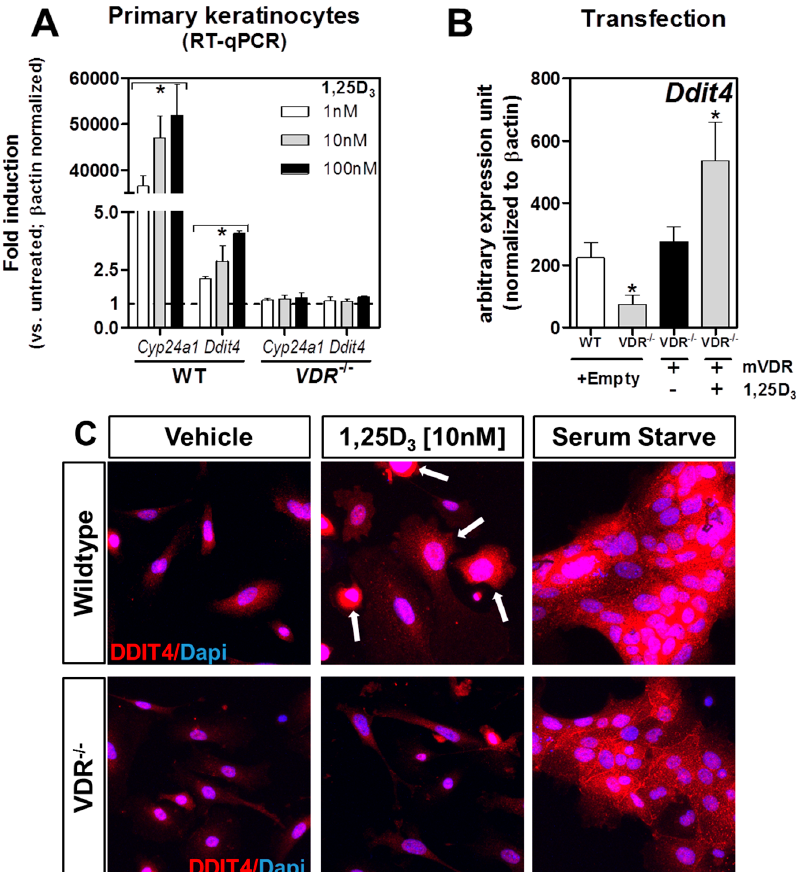
Figure 2. Regulation of the mechanistic/mammalian target of rapamycin (mTOR) inhibitor and stress sensor DNA damage-inducible transcript 4 (Ddit4) by liganded vitamin D receptors (VDRs) within primary keratinocytes (column 1.5). ( A ) Dose-dependent transcriptional induction of Cyp24a1 and Ddit4 by 1,25-dihydroxyvitamin D (1,25D 3 , 6 h) in wildtype (WT), but not VDR − / − , primary keratinocytes derived from neonatal pups; ( B ) Transient transfection of VDR − / − primary keratinocytes with a mVDR plasmid restores endogenous Ddit4 transcript levels. Combined treatment further enhanced Ddit4 mRNA levels (with mVDR transfection and 1,25D 3 of 10 nM for 6 h); ( C ) Immunofluorescence detection of Ddit4 within primary keratinocytes. WT, but not VDR − / − , primary keratinocytes exposed to 10 nM 1,25D 3 for 18 h resulted in increased intracellular accumulation of Ddit4 (white arrows). Ddit4 upregulation in response to fetal bovine serum deprivation for 24 h in both WT and VDR − / − keratinocytes. One-way ANOVA at an α = 0.05 (95% confidence interval) and Tukey’s multiple comparison post-tests were utilized. Significance is denoted with asterisks: * p < 0.05 ( n = 3–4 experiments). RT-qPCR: reverse transcription quantitative polymerase chain reaction.